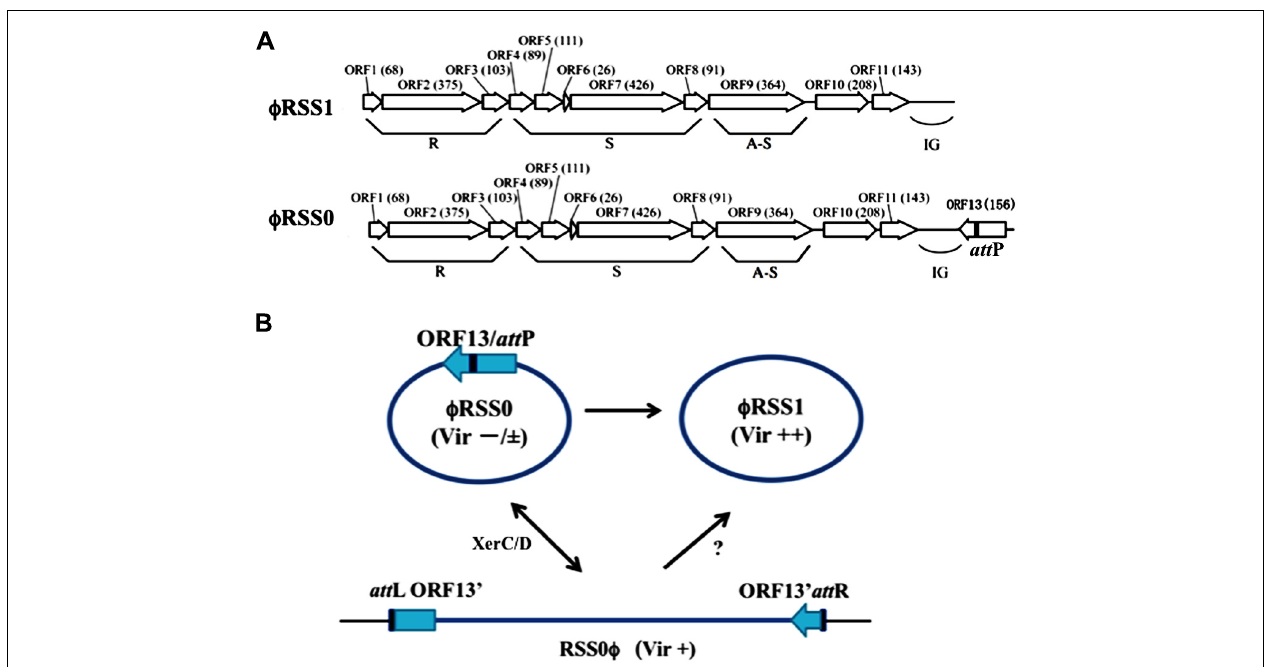
FIGURE 1 | φ RSS type filamentous phages infecting R. solanacearum. (A) Genomic organization of φ RSS1 and φ RSS0 (Kawasaki etal., 2007;